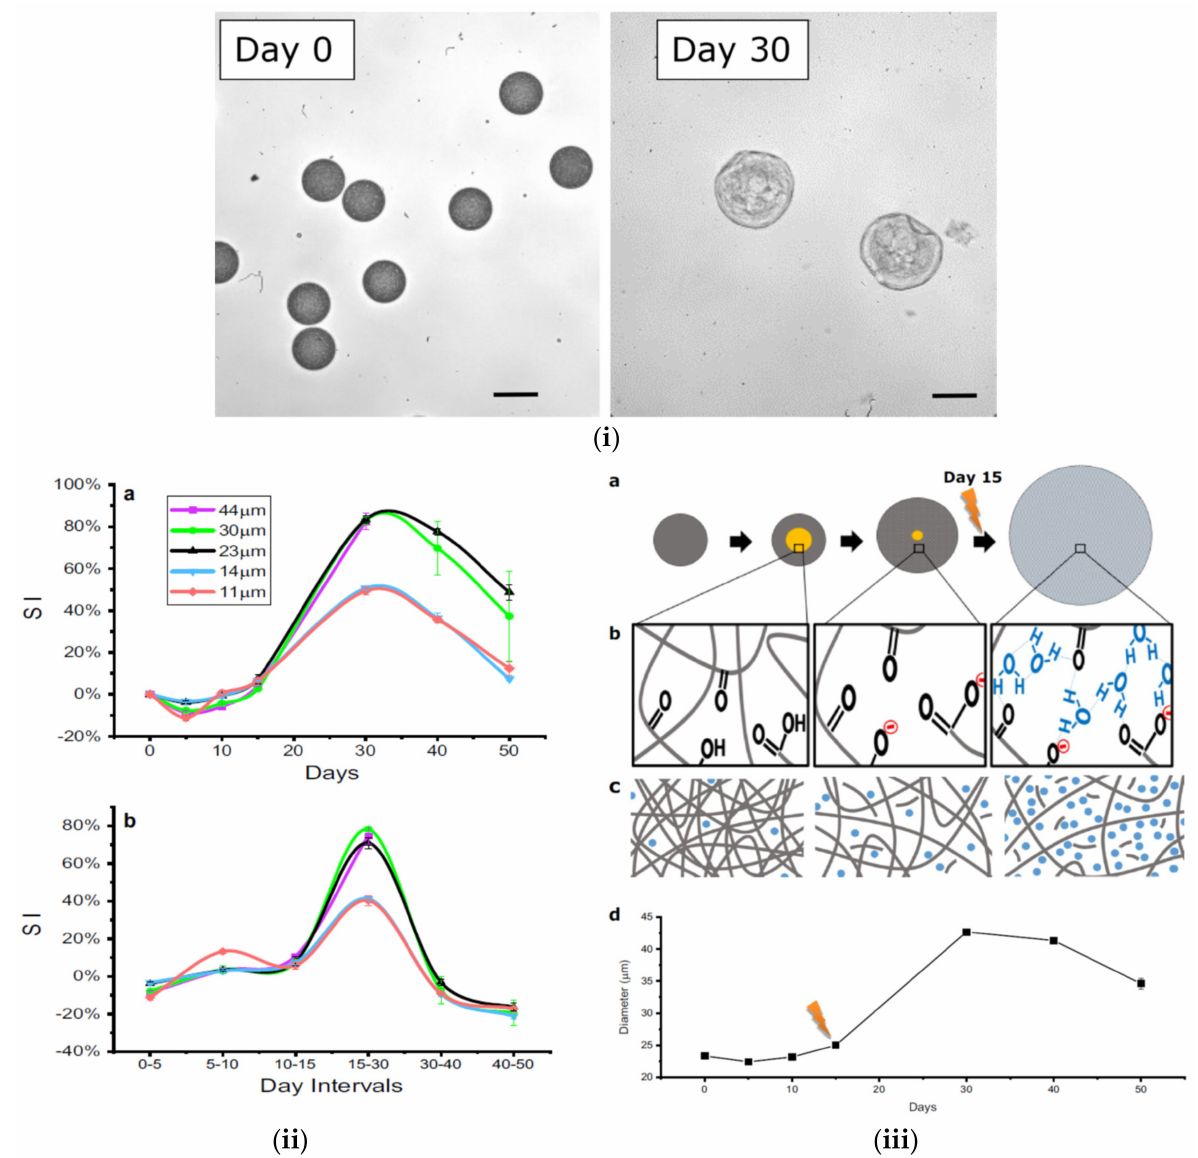
Figure 4. ( i ) Microparticle (44 µ m) swelling changes over time, on day 0 and swollen micropar- ticles (79 µ m) on day 30. ( ii ) Swelling kinetics: ( a ) Complete swelling index (SI) changes from day 0. ( b ) Swelling changes between each incubation time interval. ( iii ) Interplay of expansive intermolecular forces: ( a ) Schematic of microparticle swelling over time. ( b ) Insets represent the hy- drolysis, degradation, hydration shell, and swelling that occurs over time in terms of active chemistry. ( c ) General view of water ingress over time and subsequent hydrolysis of the polymer, ( d ) Swelling profile timeline as it correlates with the schematic (taken from 23 µ m population data)